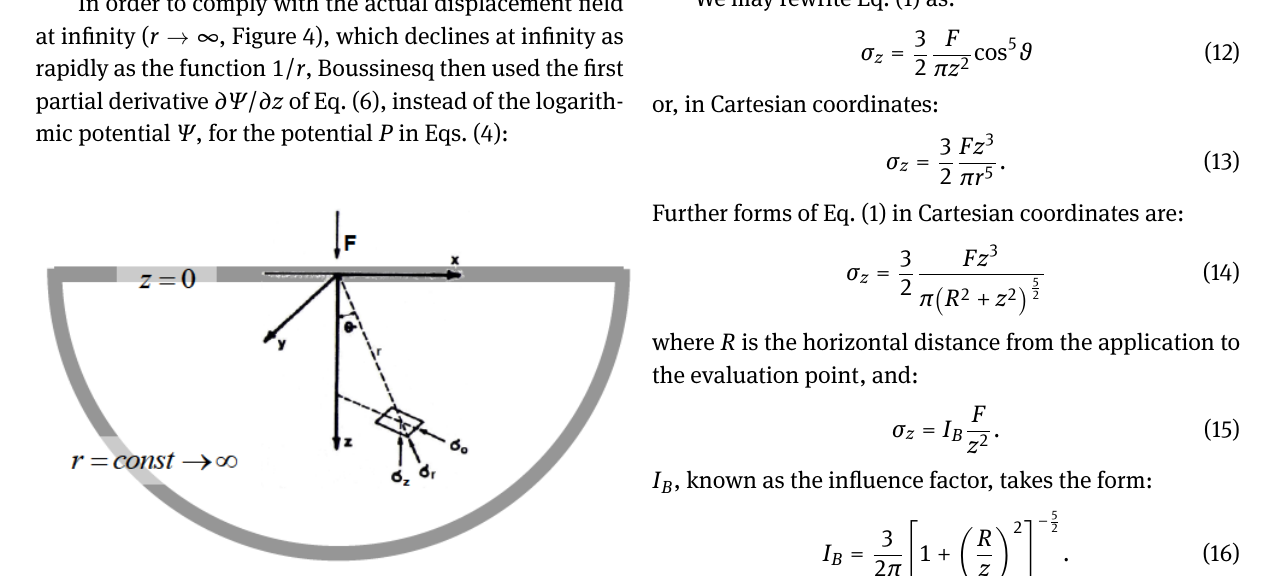
Figure 4: The boundary of the